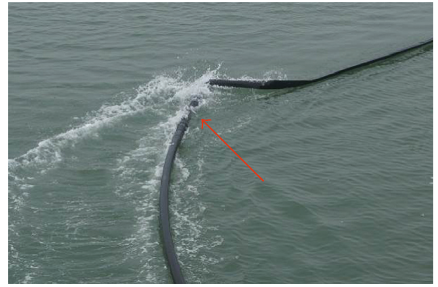
Figure 42: Encountering strong currents.